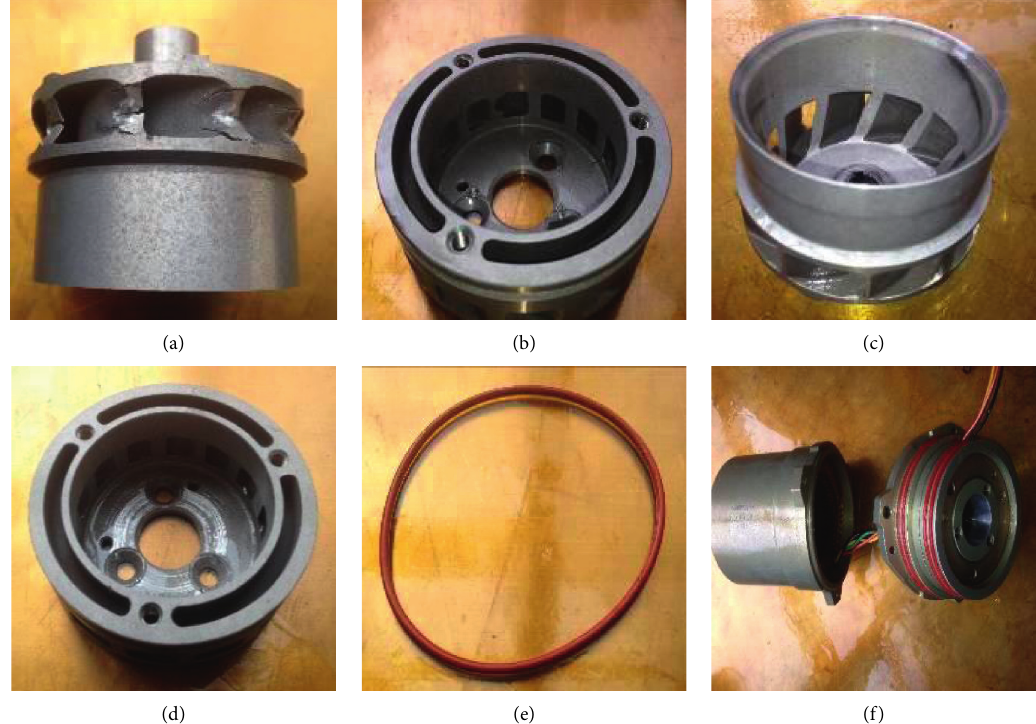
Figure 6: Typical faults of airborne fuel pump. (a) Blade damage; (b) Diffusion pipe damage; (c) Pump port and impeller rub; (d) Diffusion pipe and impeller rub; (e) Sealing ring aging; (f) Bearing